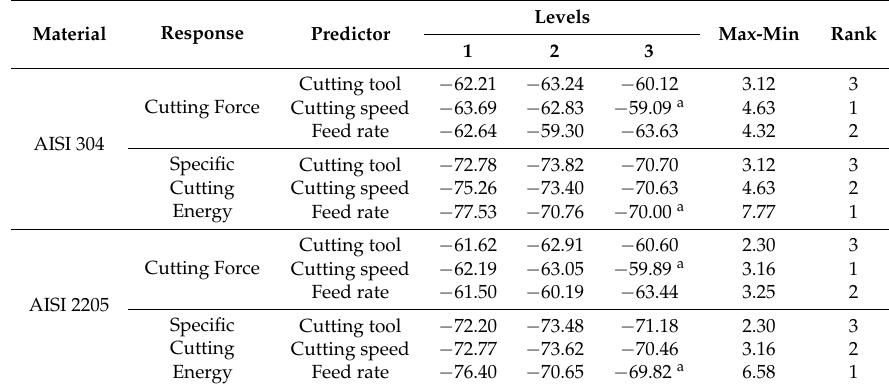
Table 8. Response table mean S/N ratio for cutting force and specific cutting energy factors and significant interaction.